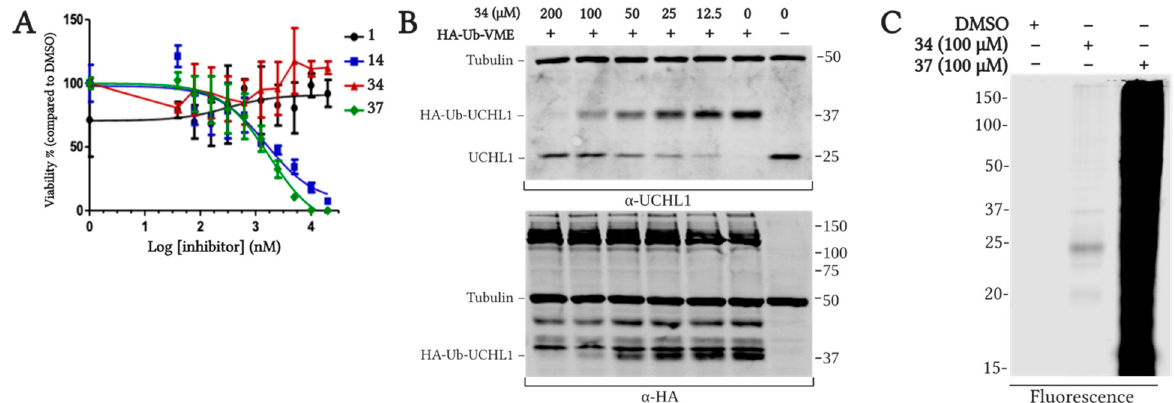
Figure 8. SW1271 small cell lung cancer cell viability and on target engagement of inhibitors. ( A ) Cell viability of the SW1271 cell line in the presence of selected fluoromethylketone and chloromethylketone analogs. ( B ) Ub-ABP assay showing on-target engagement of fluoromethylketone 34 with UCHL1 in a dose-dependent manner (top panel). HA immunoblot shows selectivity for UCHL1 over other DUBs within SW1271 cells (bottom panel). Blotting for tubulin loading control shown on same HA-blot ( C ) In-gel fluorescence of SW1271 cells treated with fluoromethyl ketone 34 and chloromethylketone 37 then subjected to click reaction with Cy5-azide fluorophore.